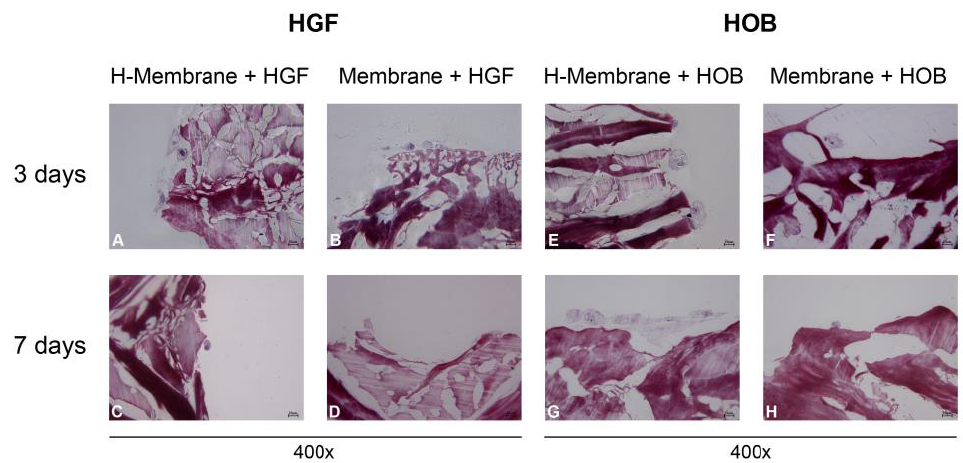
Figure 6. Cell interaction of HGFs ( A – D ) and HOBs ( E – H ) with H-Membrane and Membrane at 3 and 7 days. (Magnification = 400 × ).